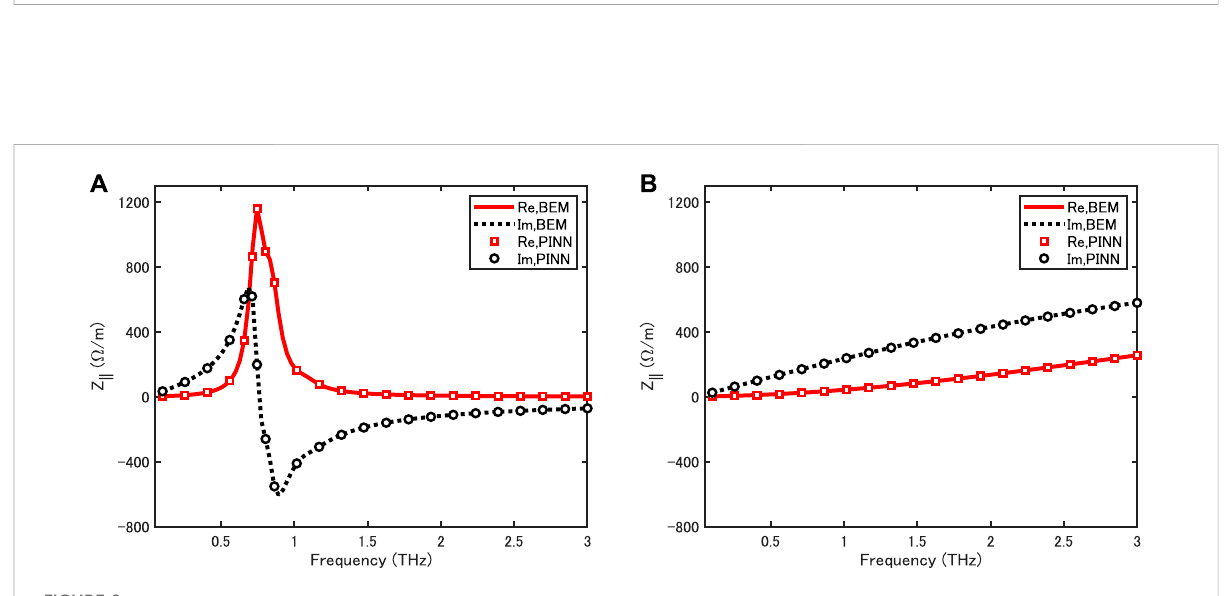
nonevaporable getter (NEG). As expected, both the real and imaginary parts of the coupling impedance decrease at each frequency point as σ c increases. For example, the impedance of